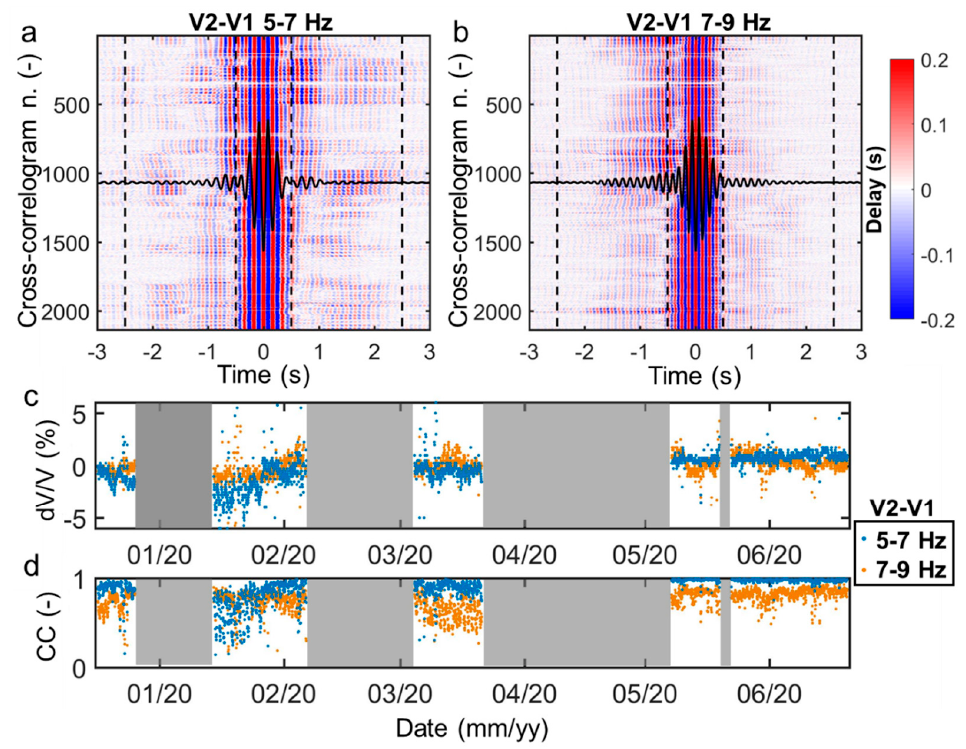
Figure 8. Cross-correlation of ambient seismic noise recorded at S2 and S1 (vertical components). ( a , b ): hourly cross-correlograms in the ( a ) 5–7 Hz and ( b ) 7–9 Hz frequency bands. The reference correlogram (average of the correlograms shown in each panel) is displayed in the center by the continuous black line. Dashed vertical black lines delimit the time intervals [–2.5 s –0.5 s] and [0.5 s 2.5 s] used for velocity change (dV/V) estimation. ( c ) Obtained hourly dV/V and ( d ) related correlation coefficients in the two frequency bands. No data periods are shaded in gray.